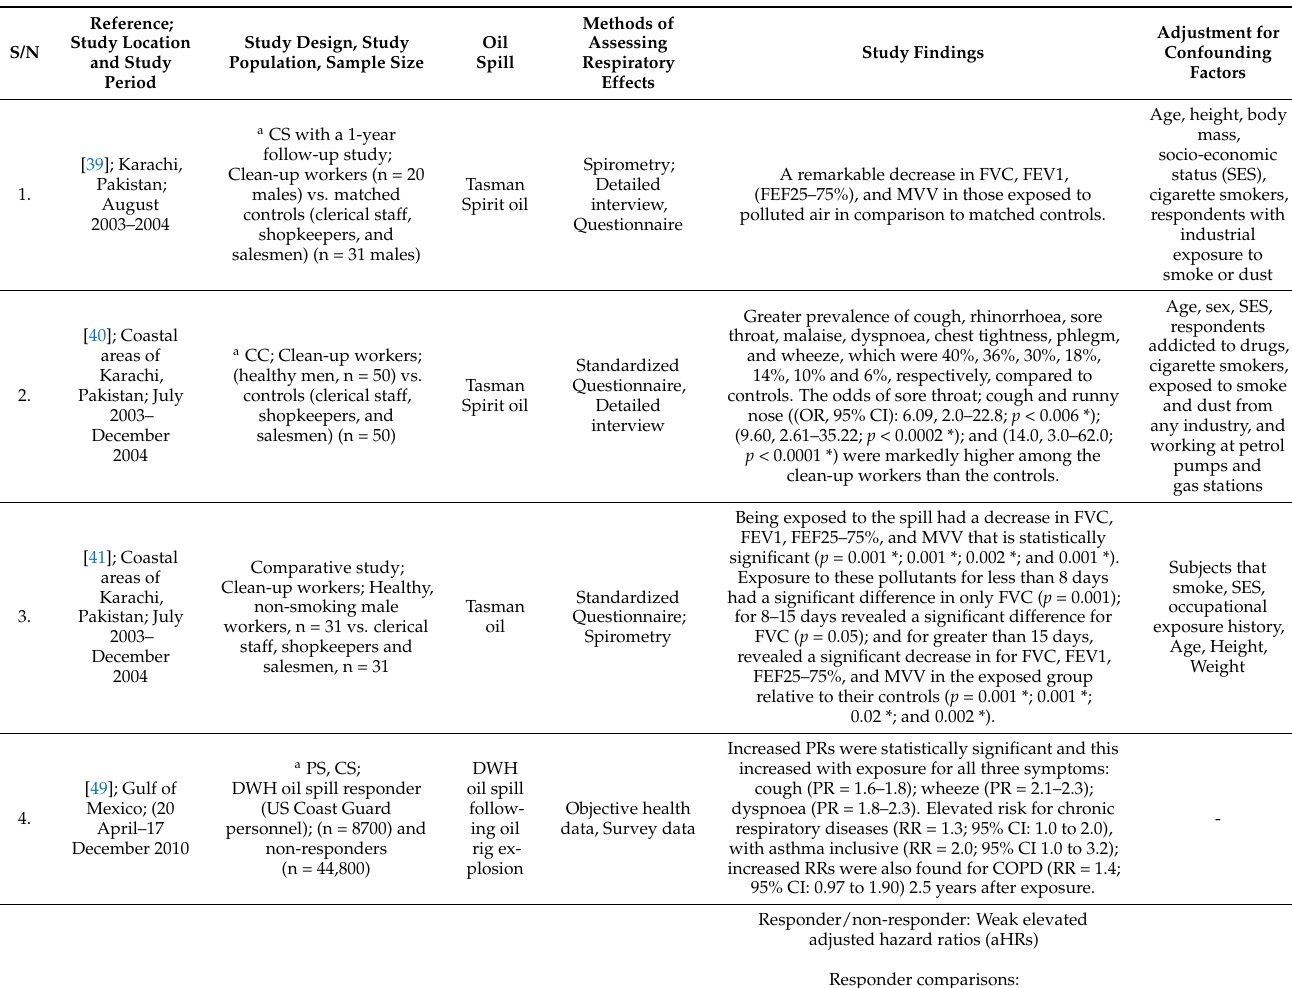
Table 2. Summary of Respiratory Health